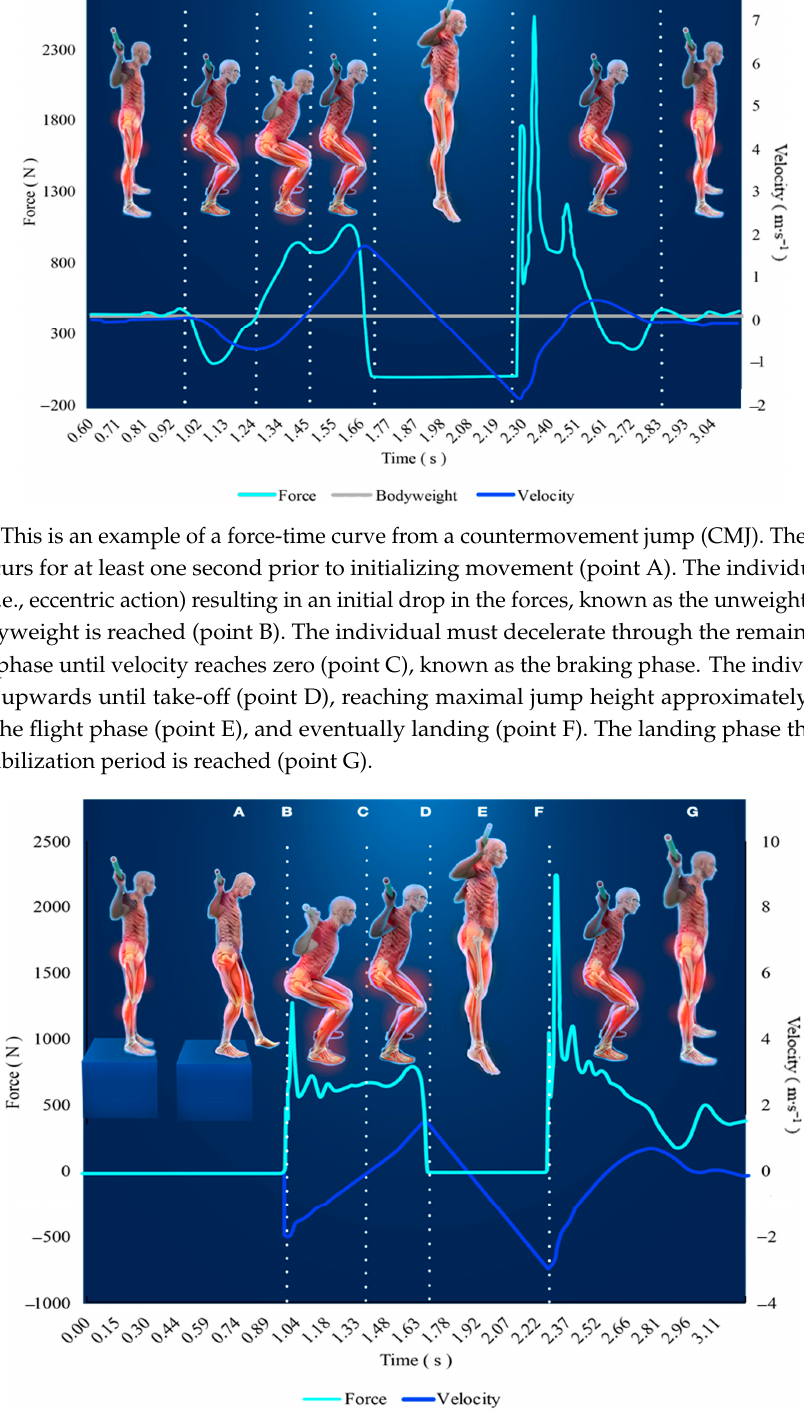
Figure 4. This is an example the force-time curve from a drop jump (DJ). The weighing phase still occurs for at least one second, but does not include capturing the individuals bodyweight. The individual begins the drop jump by stepping off, not jumping from or stepping down from, a standard height (point A) until coming into first contact with the ground (point B) and beginning the eccentric (i.e., braking) portion of the initial landing phase until velocity reaches zero (point C). As quickly as possible, the individual then explodes upwards until take-off (point D), reaching maximal jump height approximately half way through the flight phase (point E), and eventually landing (point F). The landing phase begins until a stabilization period is eventually reached (point G).